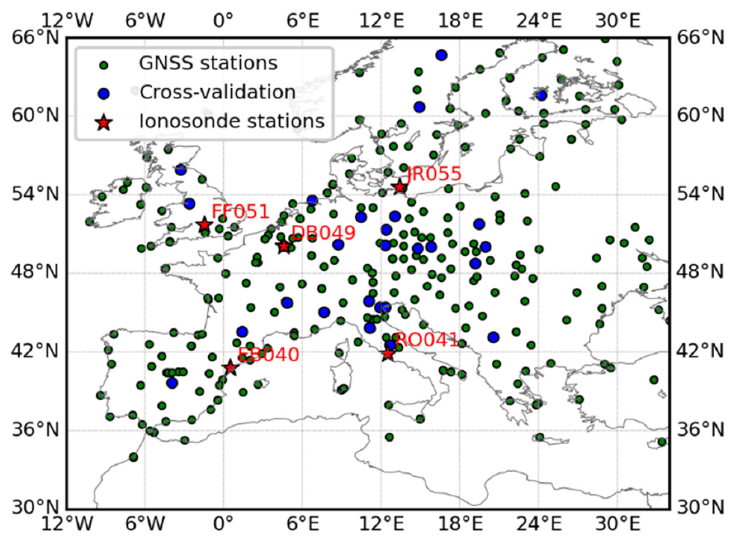
Figure 3. Study area and the distribution of GNSS stations and ionosonde stations.